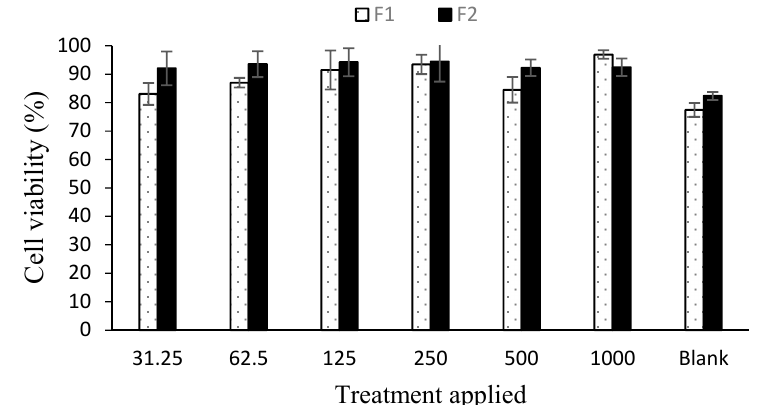
Figure 6. Cell viability analysis results ( n = 6, ± SD).